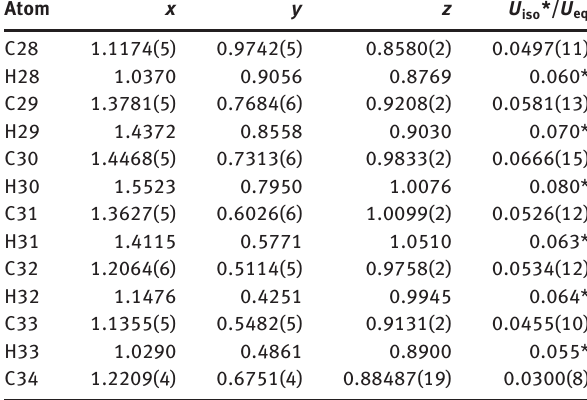
Table 2: Fractional atomic coordinates and isotropic or equivalent isotropic displacement parameters (Å 2 ).